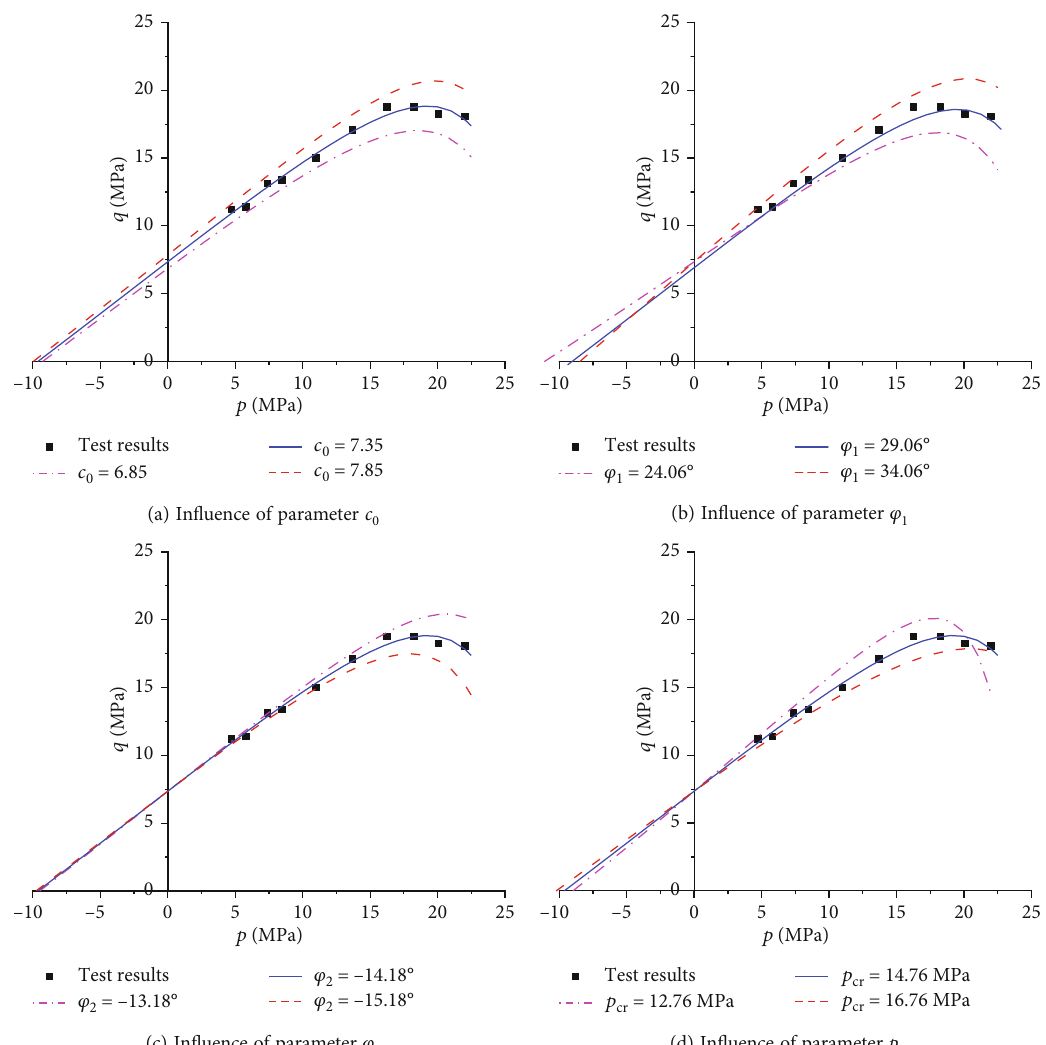
Figure 5: E ff ect of model parameter on failure strength envelope for frozen saline